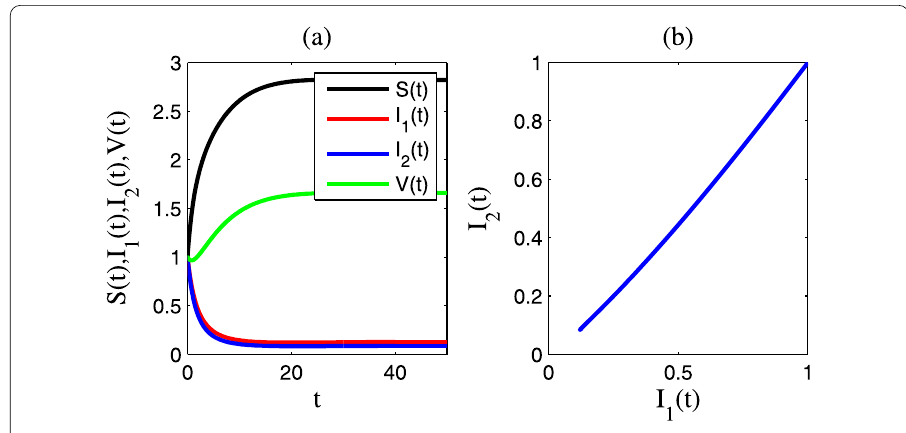
Figure 1 Time sequence diagram and phase diagram of model (4) without stochastic effects.